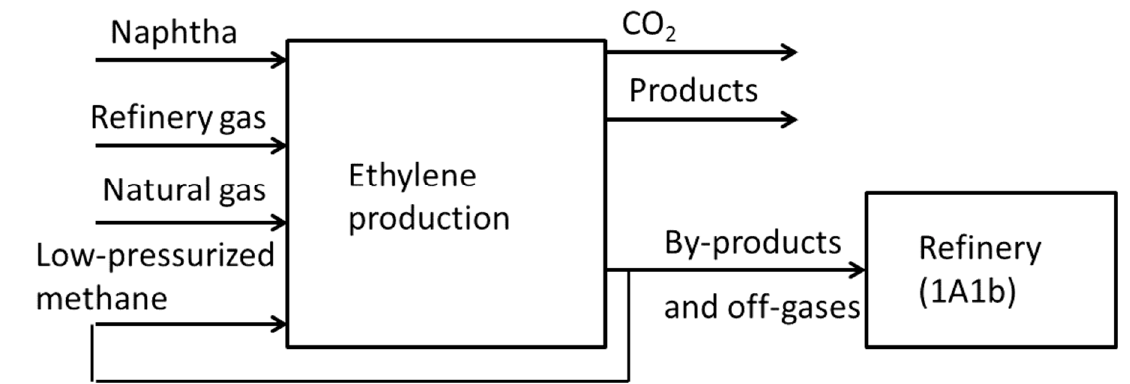
Figure 2. Scheme of the ethylene production .